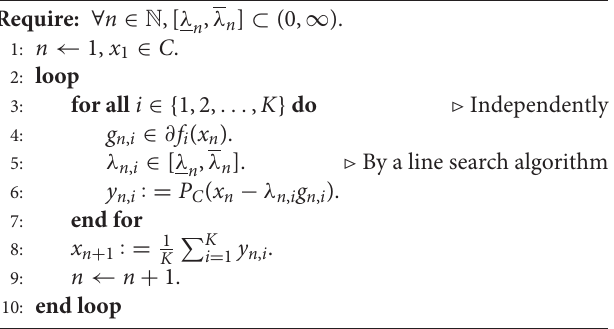
Algorithm 2: Parallel subgradient algorithm